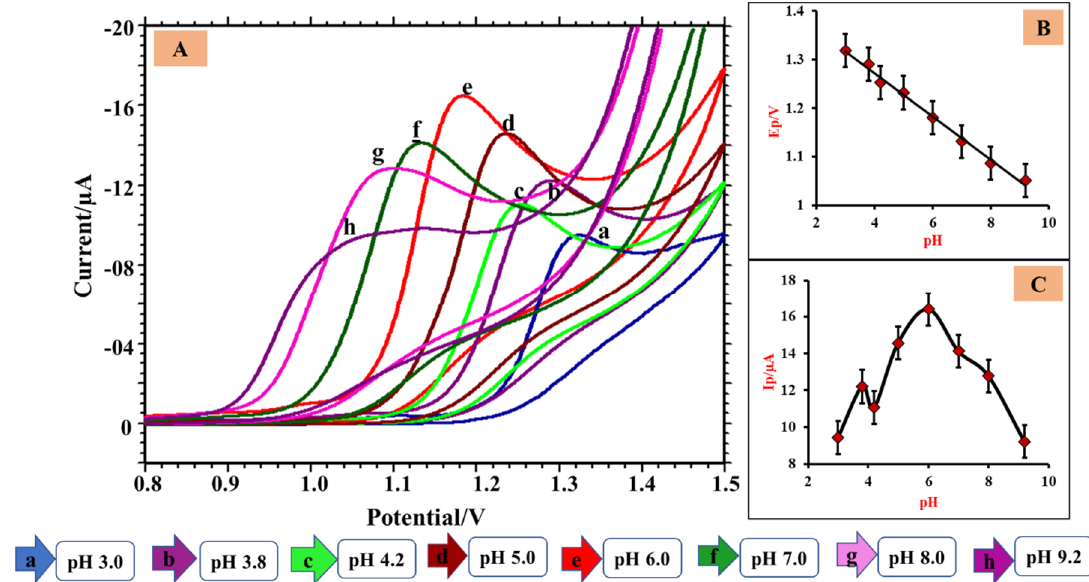
Figure 5. ( A ) Cyclic voltammograms of the THP (0.1 mM) in different electrolytic solutions in the CuO-GO/CPE; t acc = 10 s; scan rate = 0.05 Vs −1 . ( B ) Plot of E pa vs. pH. ( C ) Change in peak current with the pH.